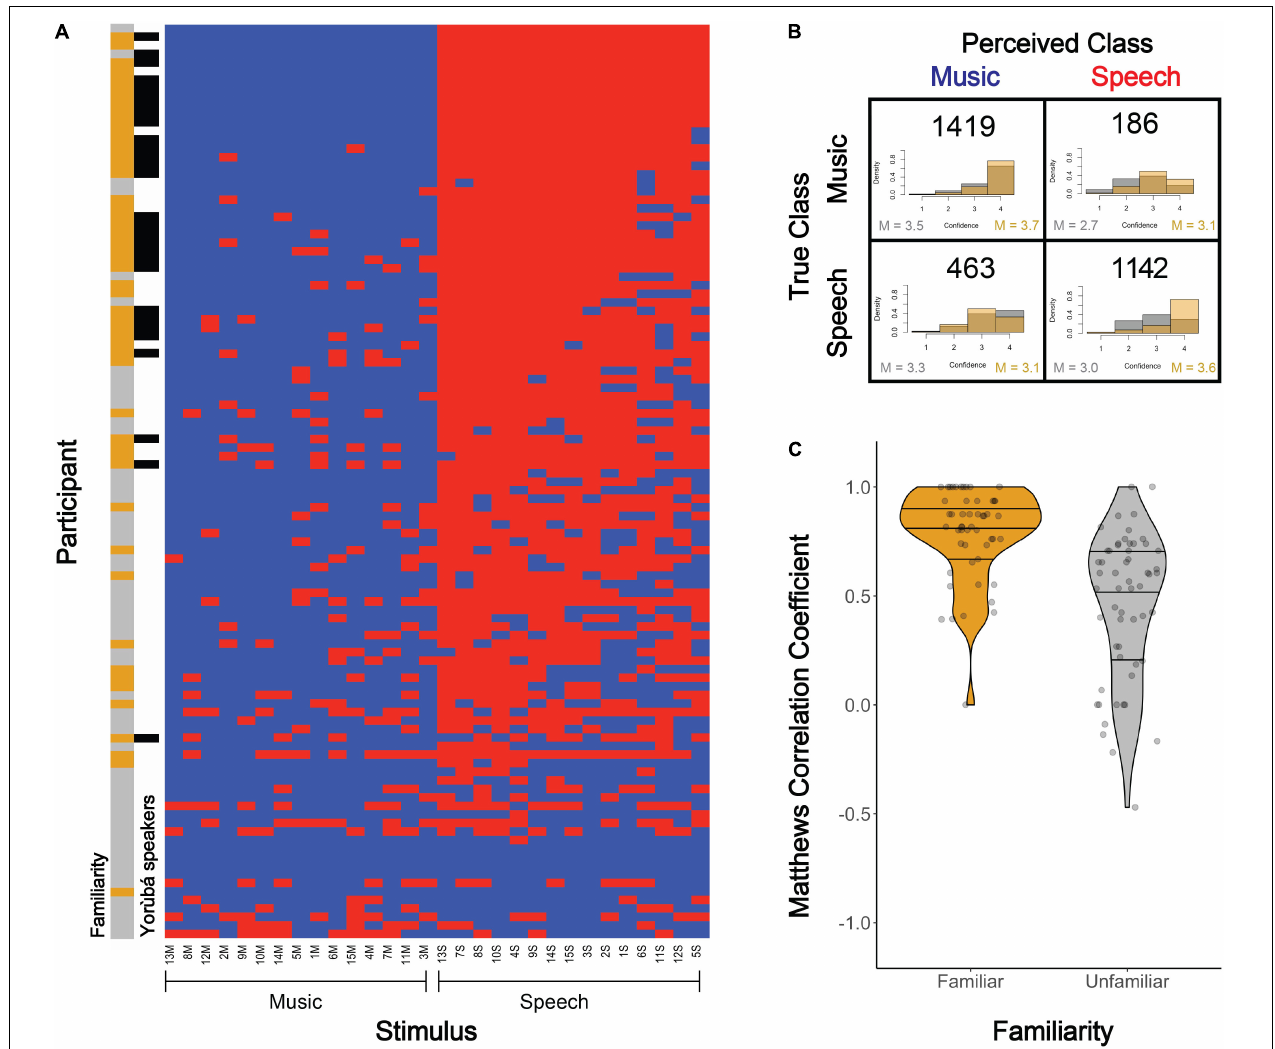
FIGURE 5 | Participants’ classification of music vs. speech-like dùndún performances. (A) Each participant’s (vertical axis) judgment of each stimulus (horizontal axis) as music (blue) or speech (red). Participant performance is sorted descending from least to most errors. Columns are sorted from left to right, within each category (speech and music), from least to most errors per stimulus. The color bar to the left of the plot indicates whether each participant was familiar (golden) or unfamiliar (gray) with the dùndún and whether they spoke Yorùbá (black) or not (white). (B) Confusion matrix for perceived vs. intended stimulus classes, with histograms of participants’ confidence ratings (1–4) for each response type (i.e., quadrant), grouped by familiarity (gold = familiar; gray = unfamiliar). Confidence rating densities were computed within each response type (quadrant) for each familiarity group separately. Means for unfamiliar (gray) and familiar (gold) groups are displayed in the lower left and right corners of each quadrant, respectively. (C) Violin plots and underlying data points indicating the Matthews Correlation Coefficient (MCC) for each participant, separated according to those who were familiar with the dùndún (golden) vs. unfamiliar (gray). The bottom and top horizontal black lines in each distribution represent the 25th and 75th percentiles, the middle line represents the median. An MCC of 1 indicates perfect classification; 0 represents chance, and -1 perfect misclassification.